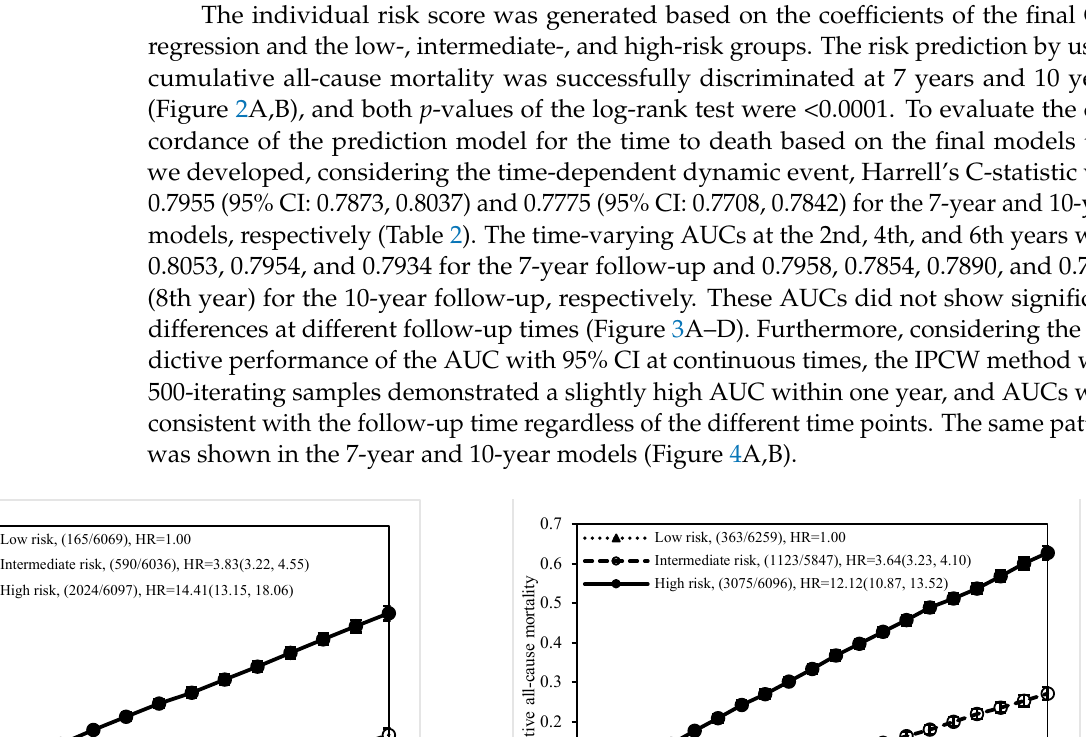
0.40.50.60.7 Low risk, (165/6069), HR=1.00 Intermediate risk, (590/6036), HR=3.83(3.22, 4.55) High risk, (2024/6097), HR=14.41(13.15, 18.06) lit y 00.10.20.3 Time (years) Figure 2. Cumulative mortality due to all causes by risk score level: ( A ) at 7 years and ( B ) at 10 years.